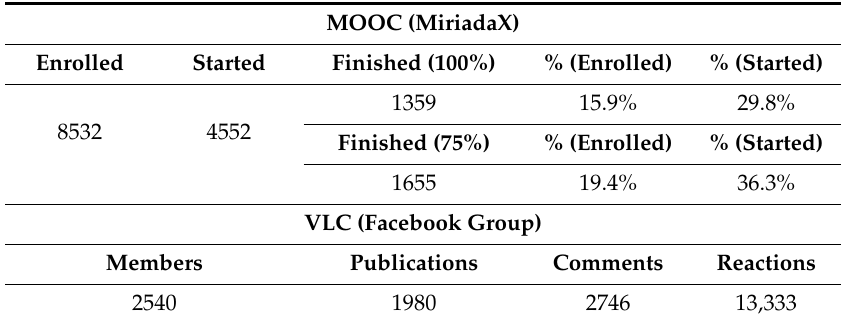
Table 2. Results of MOOC’s participation in the MiriadaX platform and Facebook